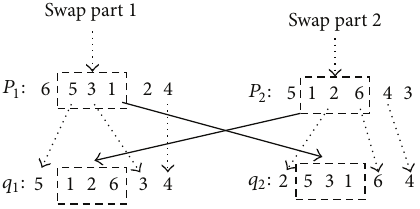
Figure 3: The process of crossover operator for control gene.